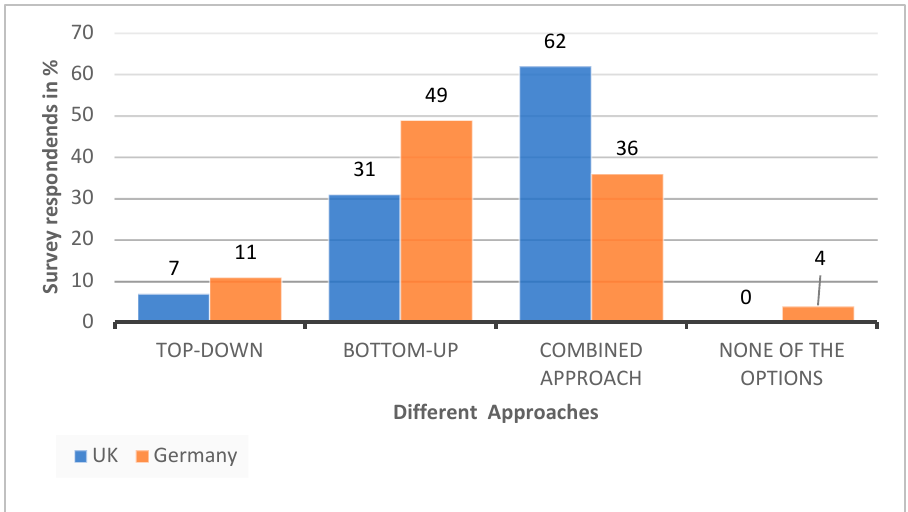
Figure 5. Comparison of UK’s and Germany’s survey results regarding the perceived governance